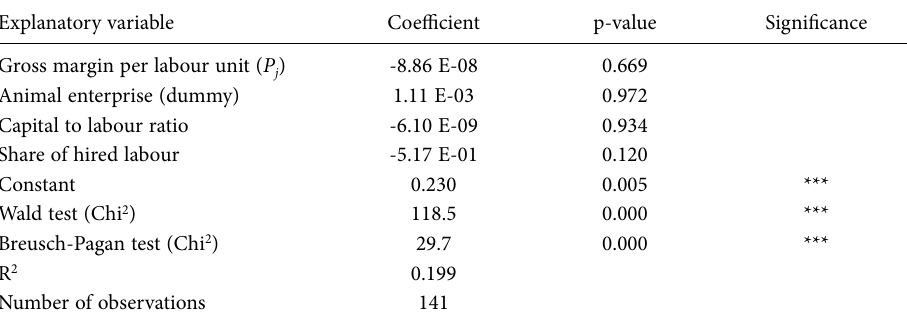
Table 4. Explaining the share of part-time farms in the country’s agricultural production, using the gross margin as the proxy for financial